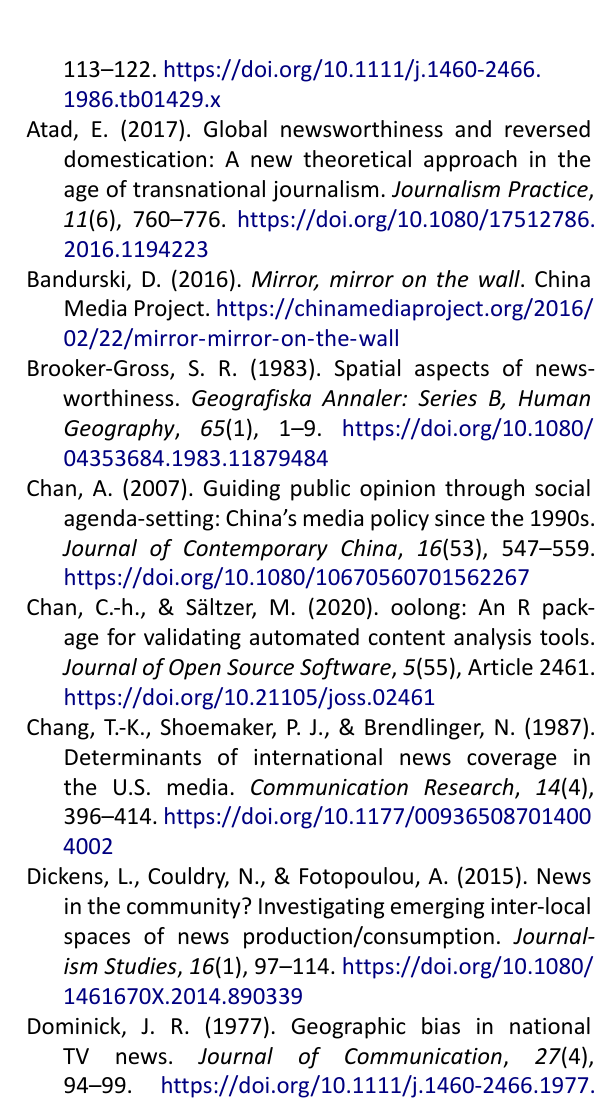
Figure 10. Prevalence difference between articles mentioning the US and other countries. Notes: Topics to the left of the dividing line are more common in articles mentioning the US, while those to the right are more common elsewhere. Lines indicate 95% CI